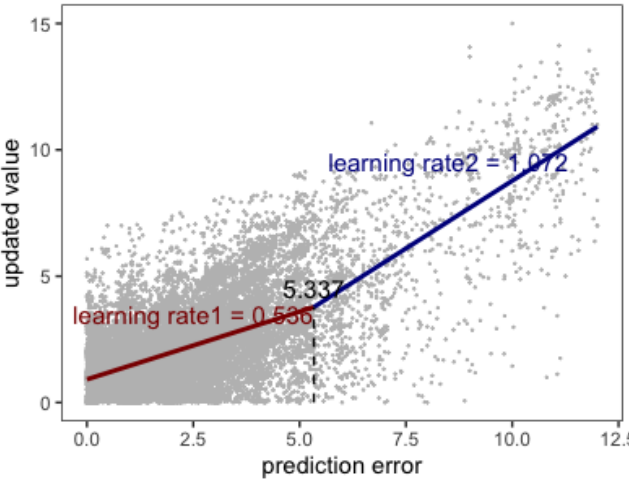
Figure 4. Segmented mixed regression. Table 6. The result of logistic regression.